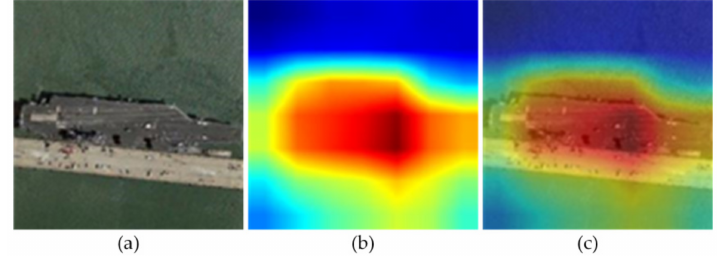
Figure 4. Visualization of Grad-CAM results. ( a ) Original remote sensing ship image. ( b ) Grad-CAM visualization image. The red part is the focus area. ( c ) Overlay of the visualized image with the original image. The area of focus is the ship